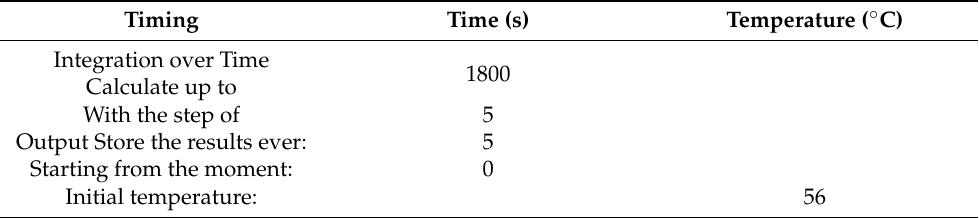
Table 1. Set-up of the integration over time of the new